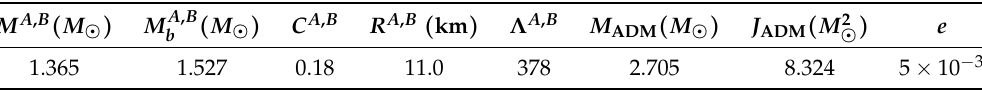
Table 1. Properties of the employed configuration. The columns refer to the individual masses in isolation, the baryonic mass of the individual stars, the stars’ compactnesses, the radii of the stars, the tidal deformability of the individual stars Λ A , B , the ADM-mass and angular momentum of the system and the estimated residual eccentricity e